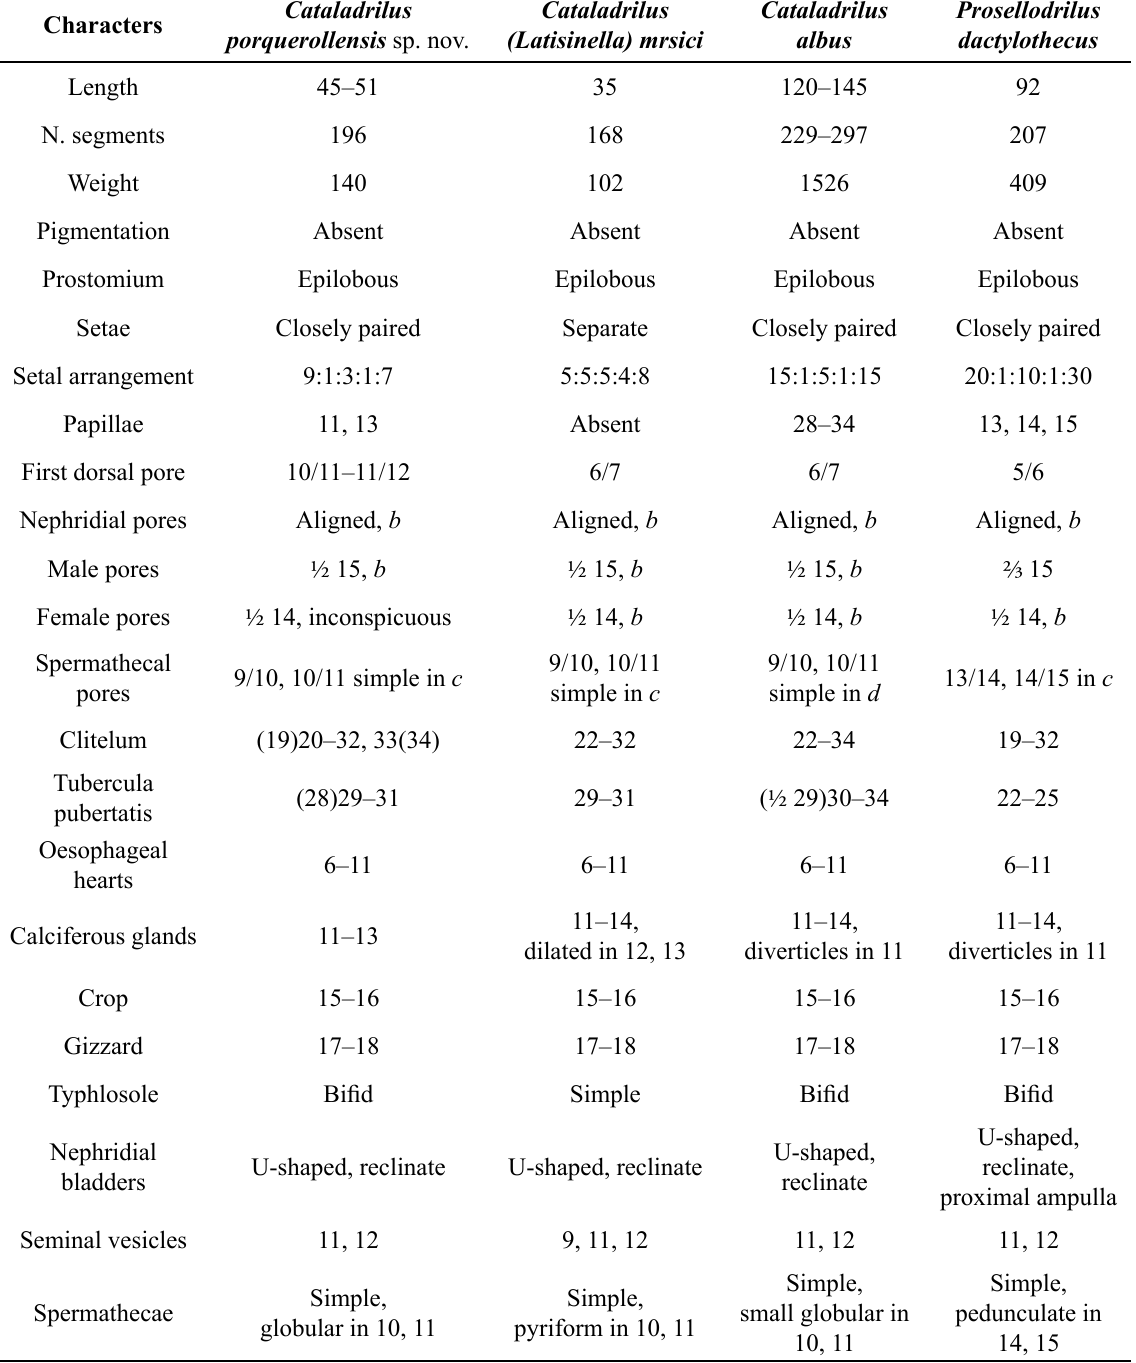
Table 3. Morphological characters of Cataladrilus porquerollensis Marchán & Decäens sp. nov. and morphologically similar relatives within the genera Cataladrilus Qiu & Bouché, 1998 and Prosellodrilus Bouché, 1972. Length expressed in mm, weight expressed in